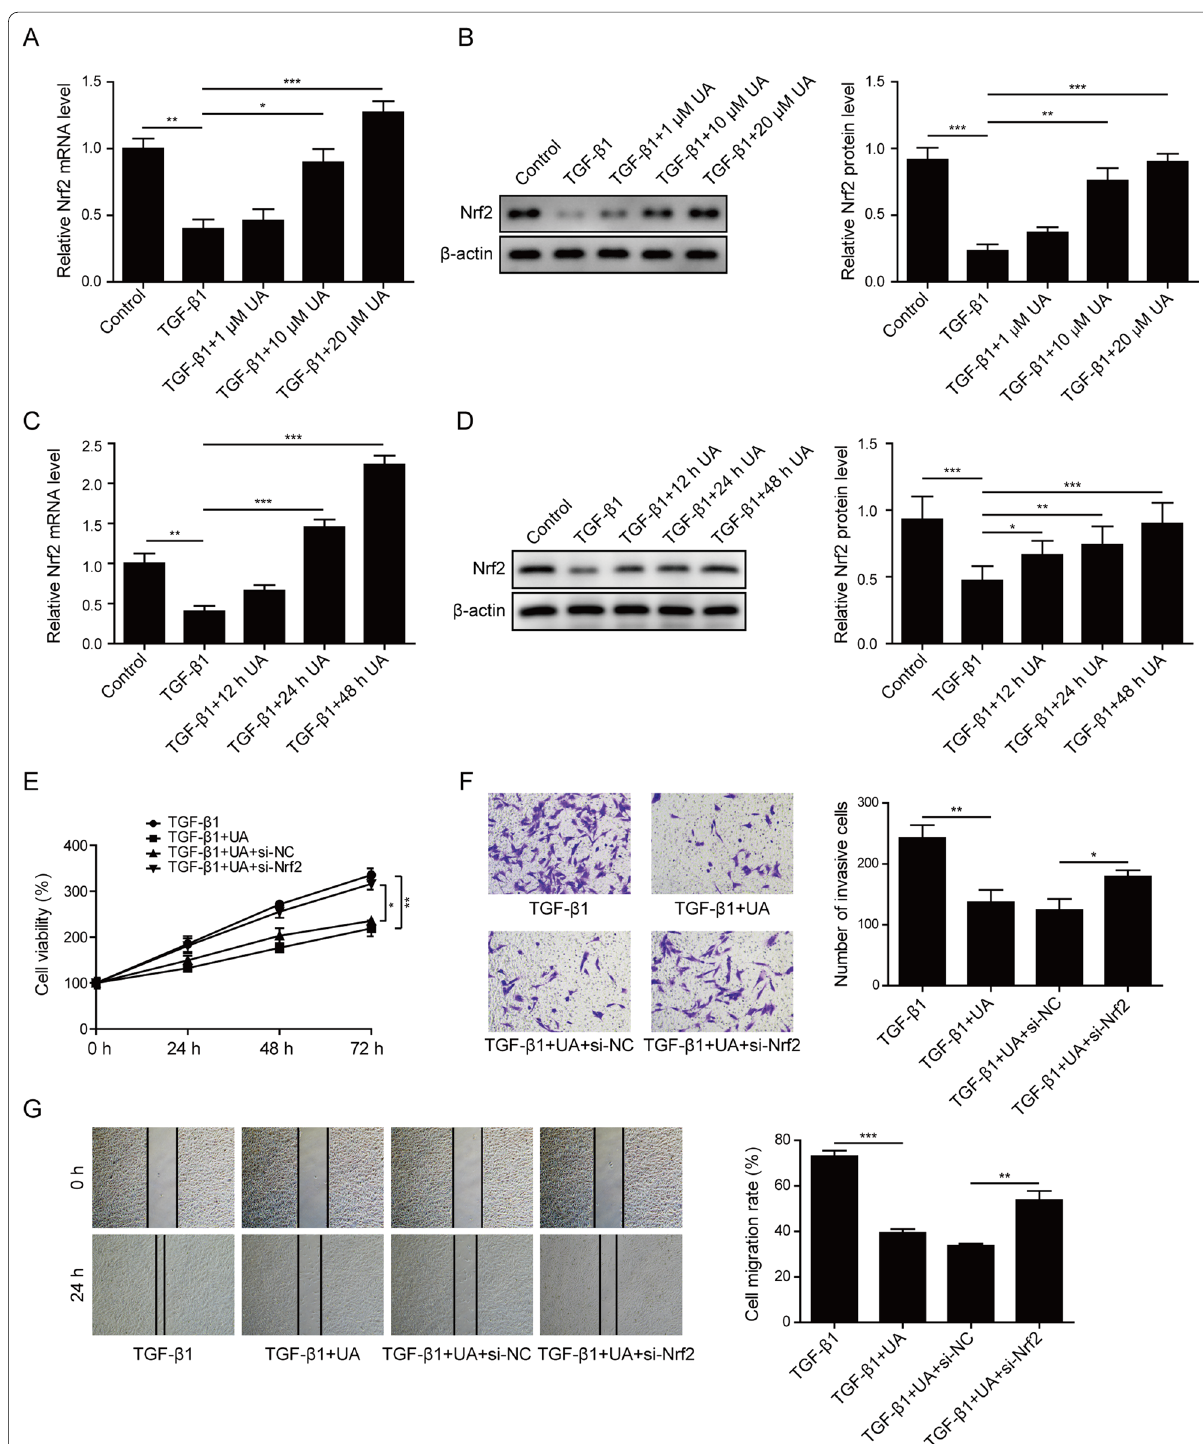
Fig. 3 UA inhibited proliferation, migration and invasion of TGF-β1-stimulated CFs through activating Nrf2. A and C The mRNA level of Nrf2 in CFs after indicated treatments. B and D The protein level of Nrf2 in CFs after indicated treatments. β-actin was used as normalized control. E Cell viability was measured by MTT assay of CFs after indicated treatments. F Cell migration was measured by wound healing assay of CFs after indicated treatments. G Cell invasion ability was measured by transwell assay of CFs after indicated treatments. N